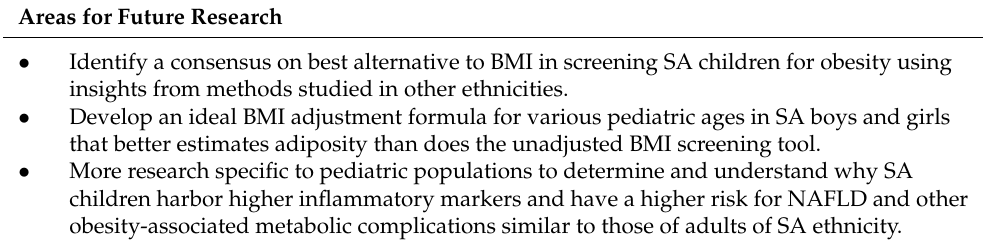
Table 5. Areas of future research to facilitate management of pediatric obesity in SAs. Areas for Future